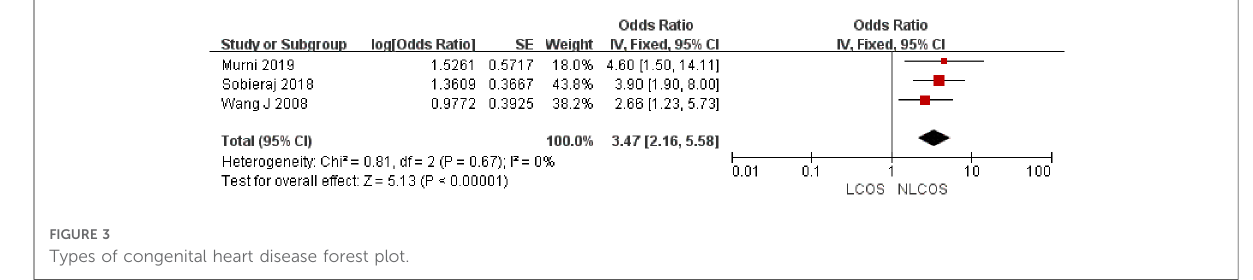
FIGURE 3 Types of congenital heart disease forest plot.